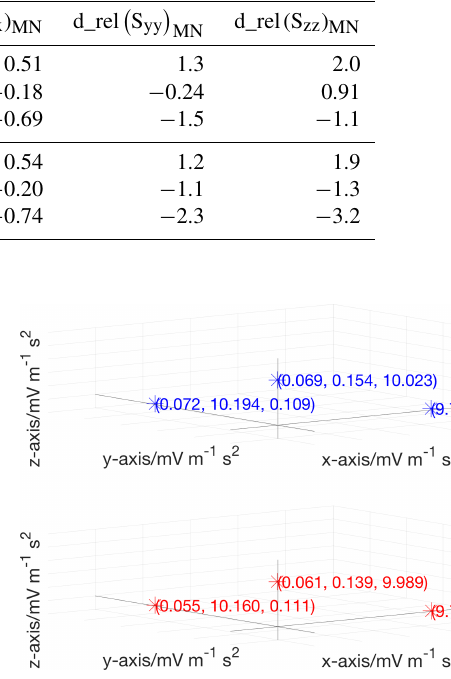
Figure 7. Piezo-electric accelerometer: sensitivity matrix obtained by means of Method 1 (3-D